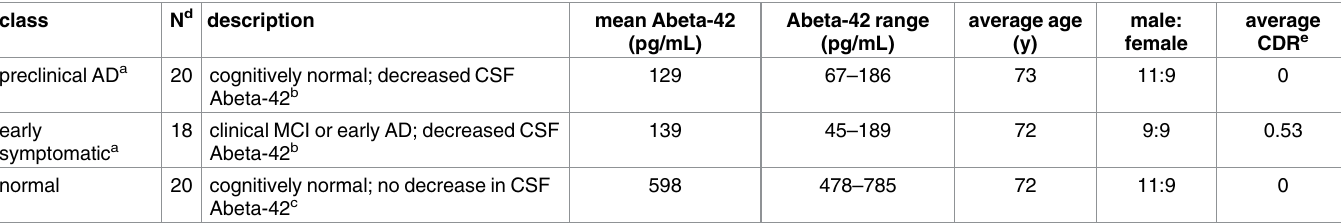
at preclinical and early-symptomatic stages using a limited number of human plasma samples. For this application, we analyzed samples from patients with preclinical and early symptomatic stage AD, and normal healthy controls (defined in Table 3), with the assumption that the Table 3. Description of patient classesfor AD